Question: What form of chart is displayed?
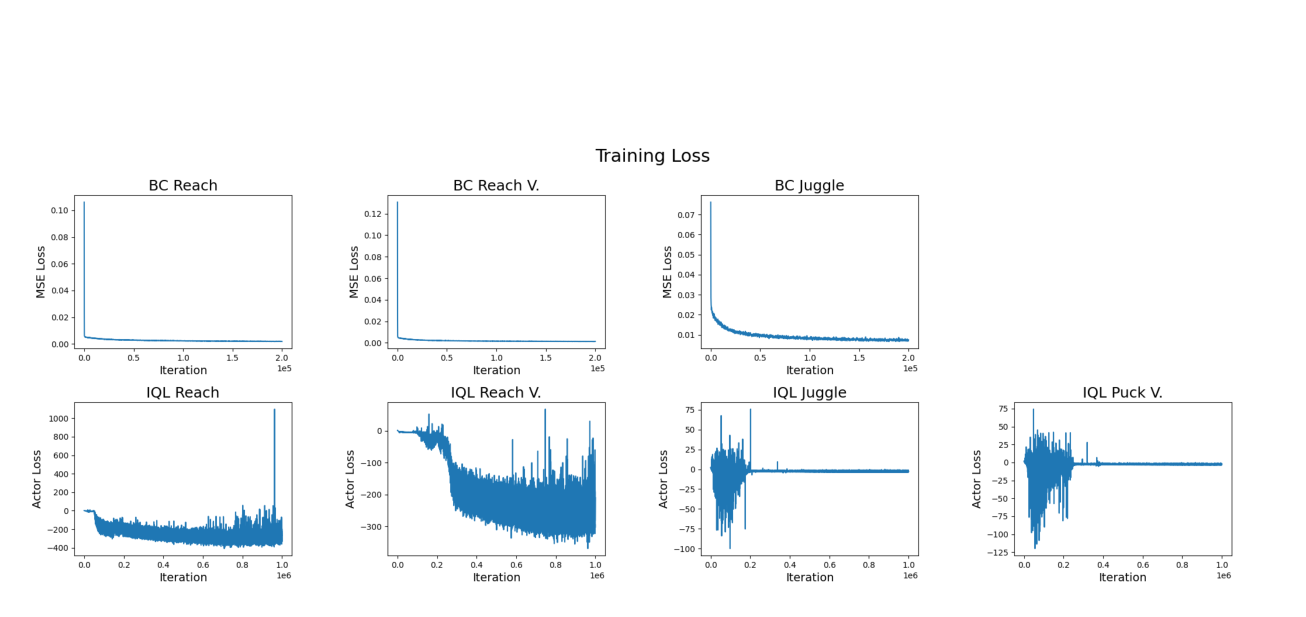
Answer: line